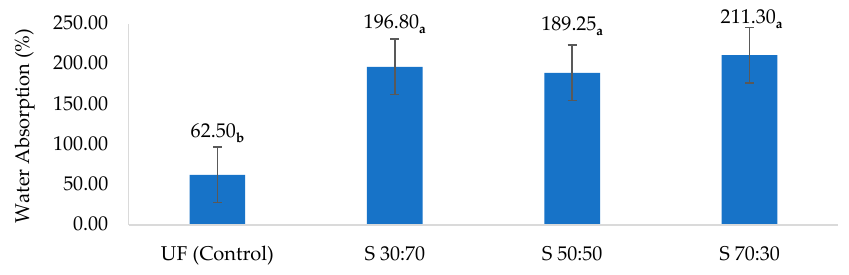
( A ) The different alphabets (a, and b) displayed beside the average values show significant differences among the parameters